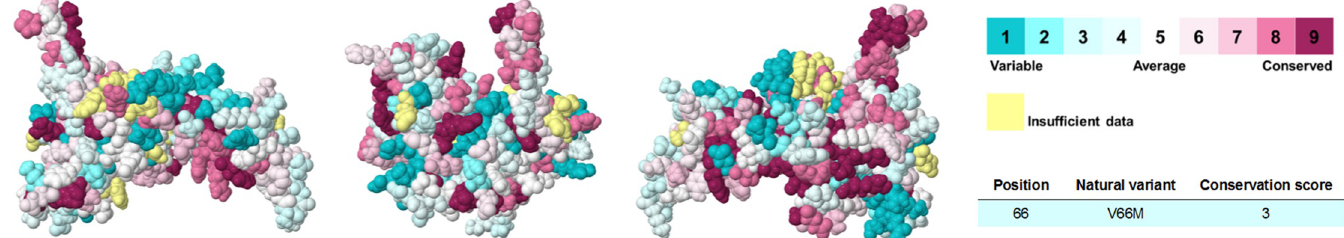
Fig 6. Evolutionary conservation analysis of BDNF. The BDNF conservation profile is shown in three different angles. The amino acid residues are represented as space-filling models and colored according to their conservation scores. The color coding bar shows the ConSurf conservation scores. The amino acid residues colored in yellow did not receive conservation scores due to insufficient data. According to ConSurf, position 66 of BDNF is variable and buried. Highly conserved positions are colored maroon, intermediately conserved residues are colored white and variable positions are colored turquoise.